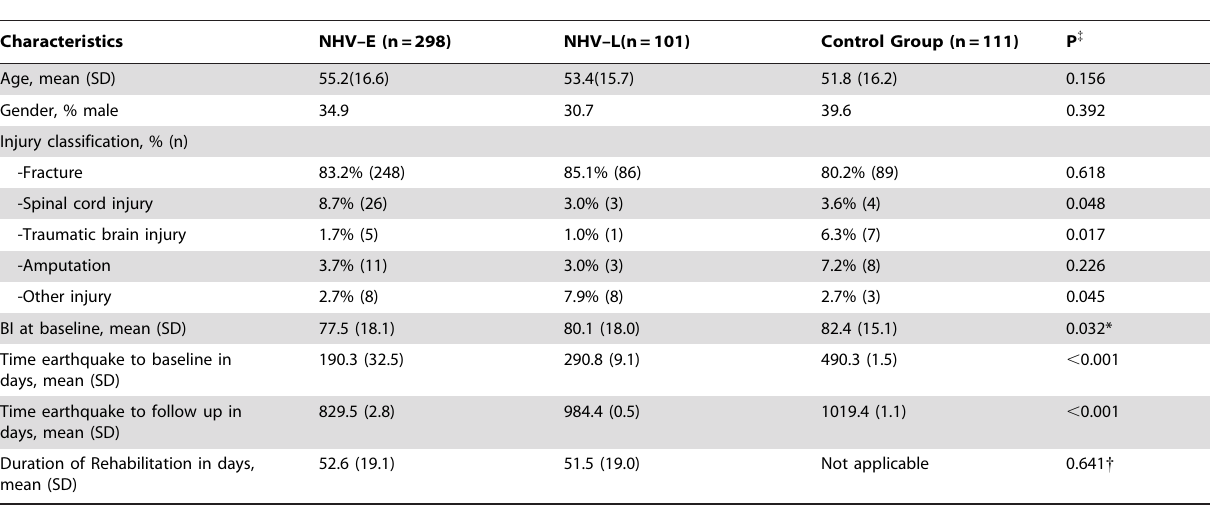
Table 1. Baseline characteristics of the NHV study